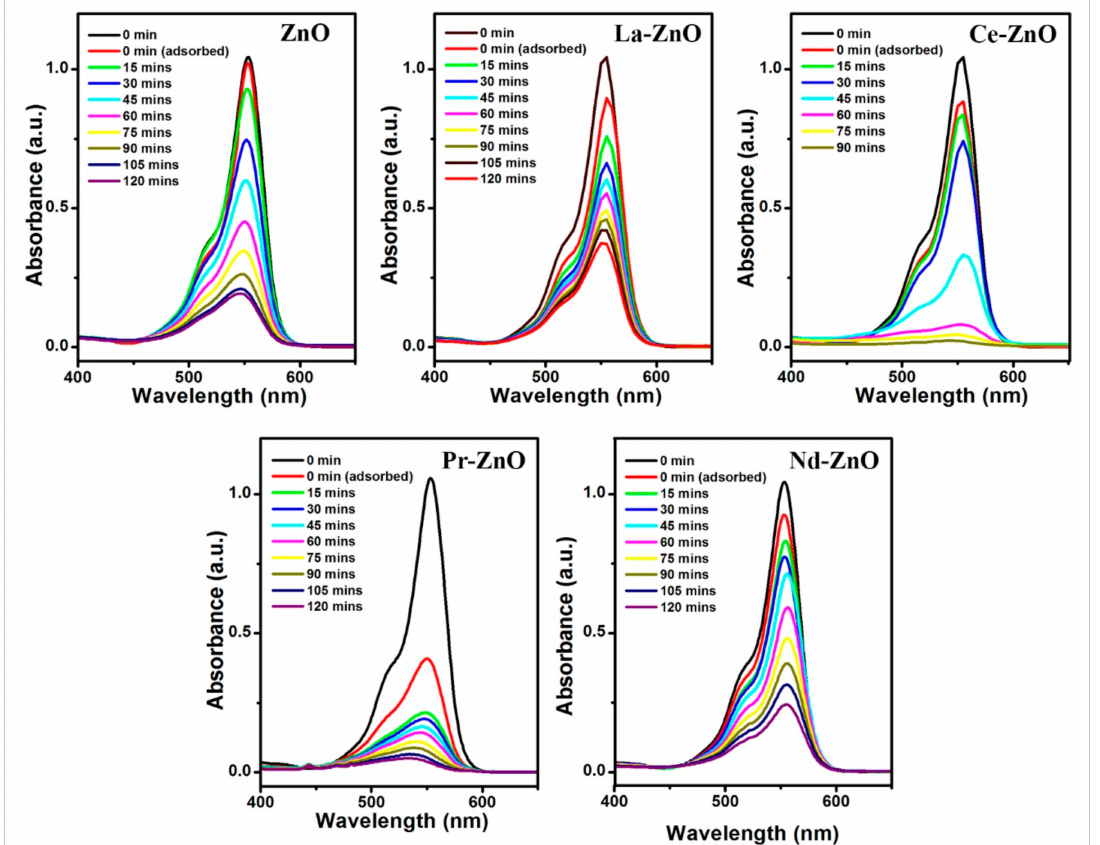
Figure 7. UV–Vis absorption spectra of the RhB dye in the reaction mixture as a function of time t in the presence of the photocatalysts under study and upon irradiation with UV light. Data are given for nanoparticles calcined to 500 ◦